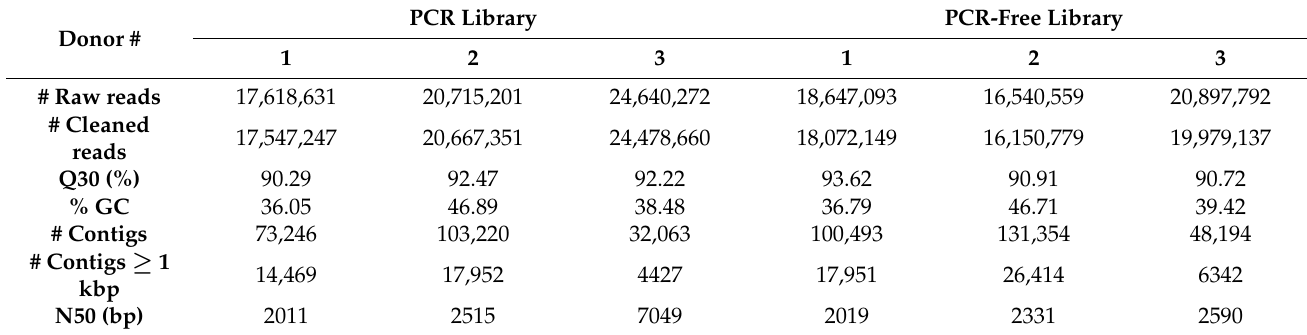
Table 1. Sequence read quality and quantity of PCR and PCR-free datasets.